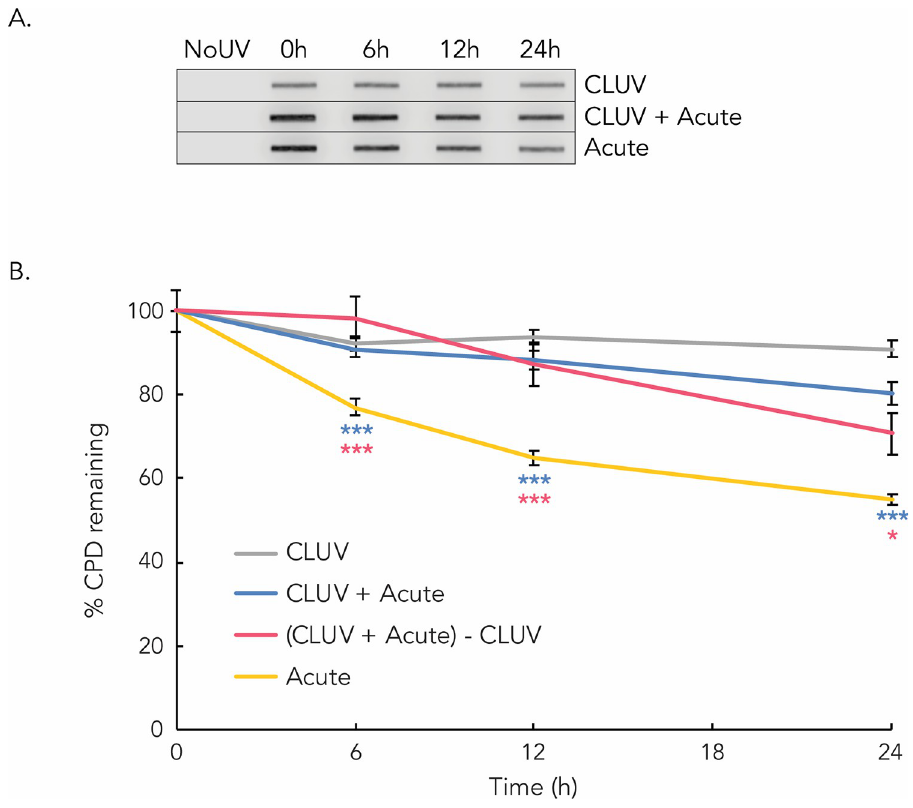
Fig 2. Repair kinetics of UVB-induced CPD in keratinocytes. Confluent keratinocytes were exposed to a chronic UVB-irradiation protocol ( i . e . CLUV protocol; 75 J/m 2 UVB, every 12 h, during 7.5 days for a total of 15 irradiations), an Acute irradiation (single exposure to 400 J/m 2 UVB) or a combination of CLUV+Acute exposure. ( a ) The amount of UVR-induced CPD was assessed by immuno-slot-blot at 0, 6, 12 and 24 h using a specific anti-CPD antibody. Twelve hours after the last irradiation from the CLUV treatment or directly after the acute irradiation is referred as T = 0. Blot was cropped from different part of the same gel at the same exposure. ( b ) Quantification of the immuno- slot-blot was performed and repair kinetics were derived. Unirradiated cells (NoUV) were used as a negative control. CPD level at T = 0 was considered as 100% damage induced and the other time points were reported to T = 0. CLUV irradiation induces residual CPD that remain virtually unrepaired up to 36 h after the last irradiation. CPD induced by the acute UVB exposure are repaired efficiently leading to the removal of more than 45% of damage in 24 h. CPD induced by the CLUV pre-stimulation followed by the acute UVB irradiation (CLUV+Acute) are inefficiently repaired. Indeed, only 20% of CPD were removed in 24 h. To only evaluate the repair kinetic of the newly formed CPD induced by the Acute exposure in CLUV pre-stimulated cells, we subtracted the residual CPD from the CLUV treatment (i.e. (CLUV+Acute)-CLUV). CLUV pre-exposure significantly reduces the repair efficiency of newly generated CPD from the acute UVB irradiation. More precisely, at 24 h only 29% of acute UVB-induced CPD are repaired in CLUV pre- stimulated cells. Experiments were performed at least 7 times, in 2 independent CLUV protocols. Data presented as means ± SEM, ( *** P � 0.001, * P � 0.05), Student T-Test. Blue asterisks represent the statistical comparison between “CLUV + Acute” and “Acute” conditions. Pink asterisks represent the statistical comparison between “(CLUV + Acute)–CLUV and “Acute”